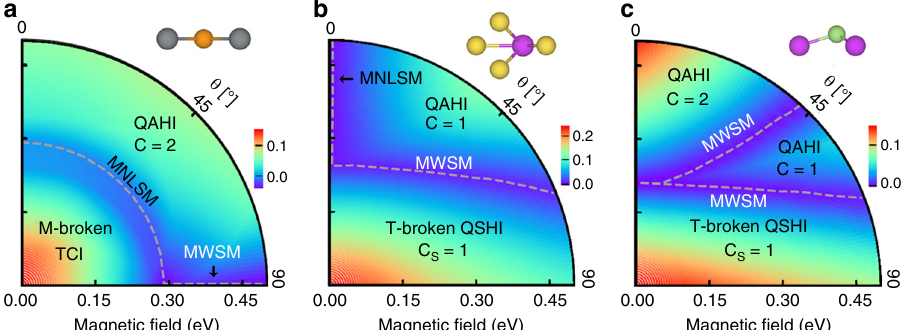
Fig. 3 Emergence of mixed topological semimetallic states. Phase diagrams of one-layer a TlSe, b Na 3 Bi, and c GaBi with respect to the magnitude B and the direction b m = (sin θ , 0, cos θ ) of the applied exchange fi eld. Side views of the unit cells highlight differences in the crystalline symmetries, and colors represent the value of the global band gap in eV. To characterize quantum spin Hall (QSHI) and quantum anomalous Hall (QAHI) phases, we use the spin Chern number C and the momentum Chern number C , respectively. Dashed gray lines mark the boundary between different insulating topological phases S for which the band gap closes. The emergent metallic states are labeled as either mixed Weyl semimetal (MWSM) or mixed nodal-line semimetal